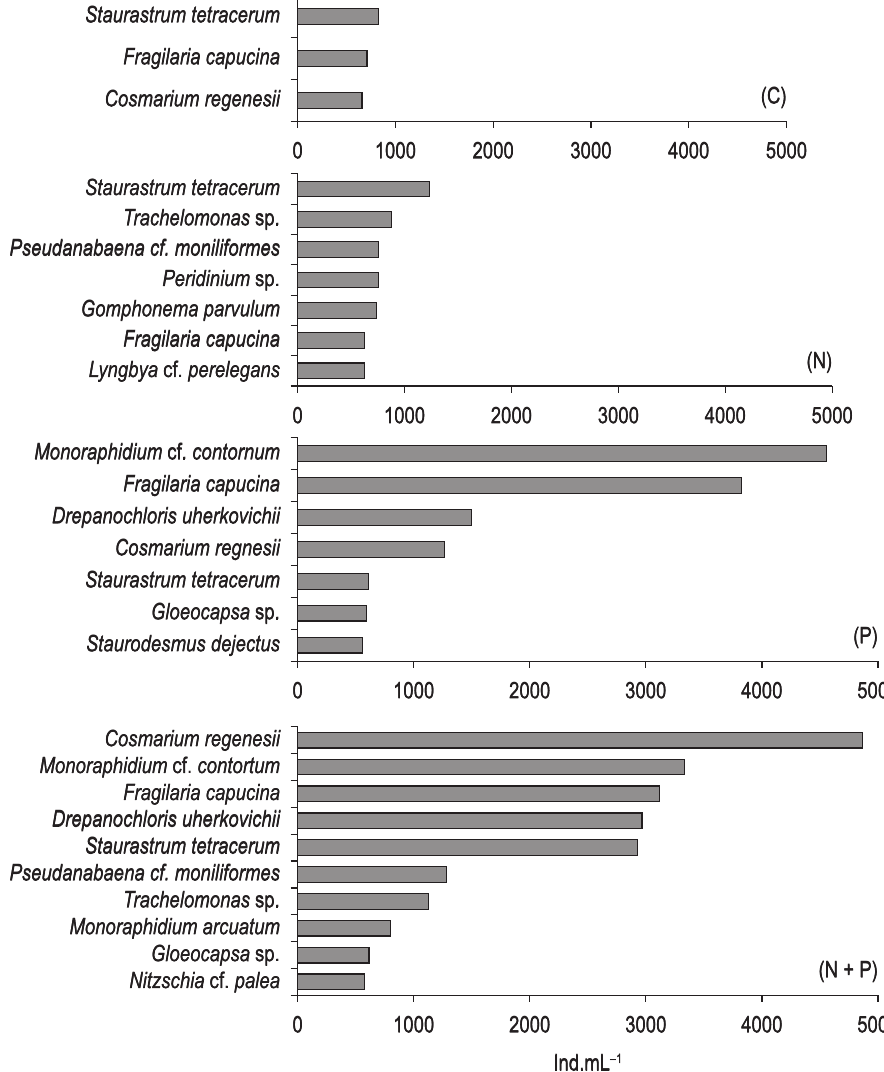
Figure 6. Abundant species contribution in each treatment of mesocosms. Control treatment (C); Nitrogen treat- ment (N); phosphorus treatment (P) and nitrogen plus phosphorus treatments